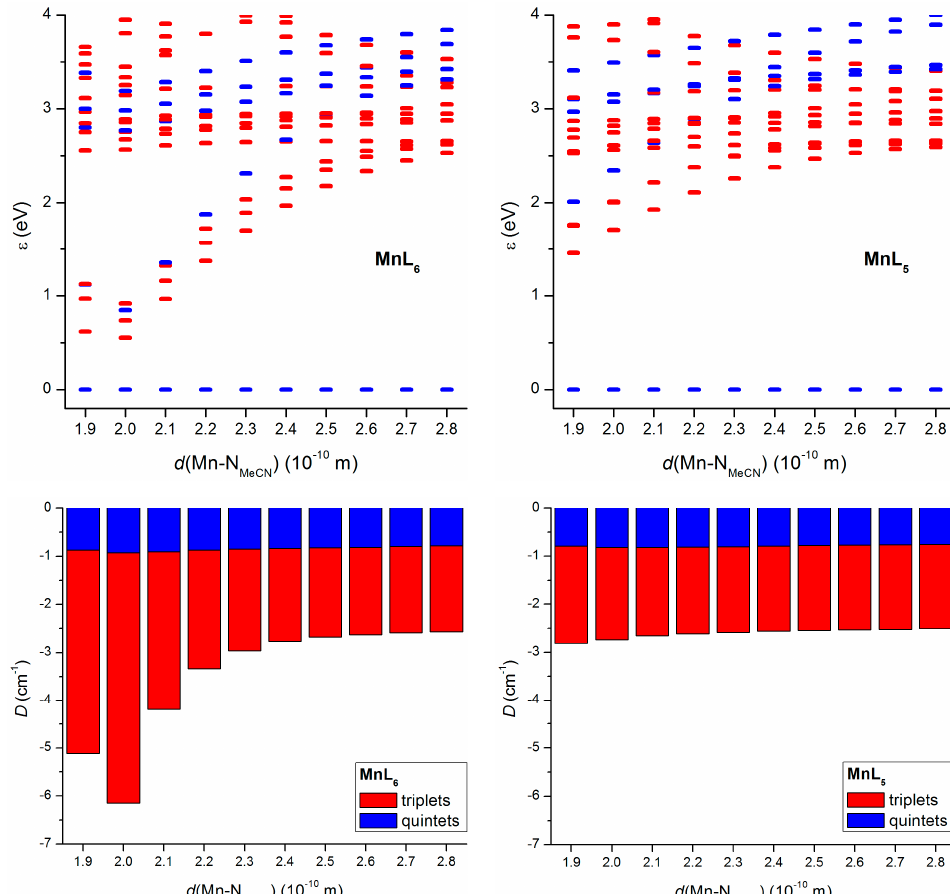
Figure 6. Top : ligand field terms arising from CASSCF/NEVPT2 calculations for the model compounds [Mn(L4A)(MeCN)]+ (MnL 5 ) and [Mn(L4A)(MeCN) 2 ] + (MnL 6 ) done for varying Mn–N MeCN distance(s) from 1.9–2.8 Å. Quintet states are blue and triplet states are red; Bottom : the contribution of quintet ( blue ) and triplet ( red ) states to the calculated D -parameter.